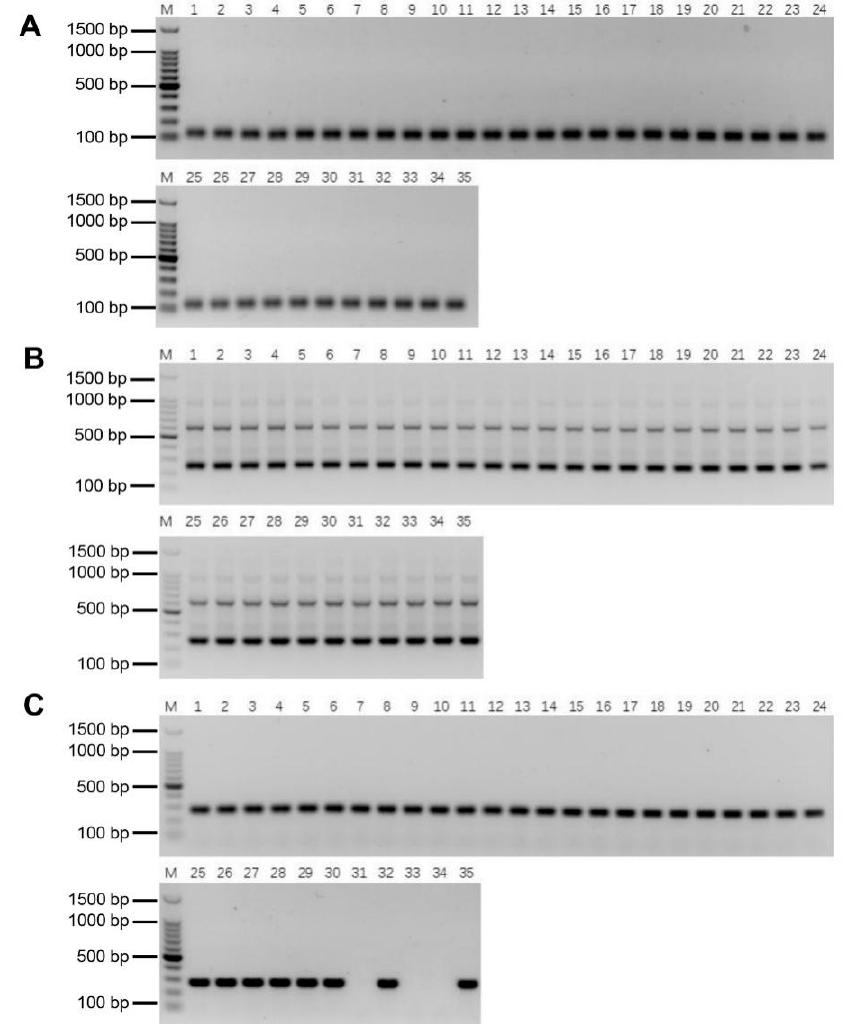
Figure 7. Validation of the stability of E. arundinaceus -specific markers. ( A ) Ea086-128 primer; ( B ) Ea009-257 primer; ( C ) EaITS-278 primer. M: 100 bp DNA Ladder; 1–5: F 1 progeny between sugarcane and E. arundinaceus ; 6–18: BC 1 progeny between sugarcane and E. arundinaceus ; 19–27: BC 2 progeny between sugarcane and E. arundinaceus ; 28–35: BC 3 progeny between sugarcane and E. arundinaceus . All samples were listed in Table S2.